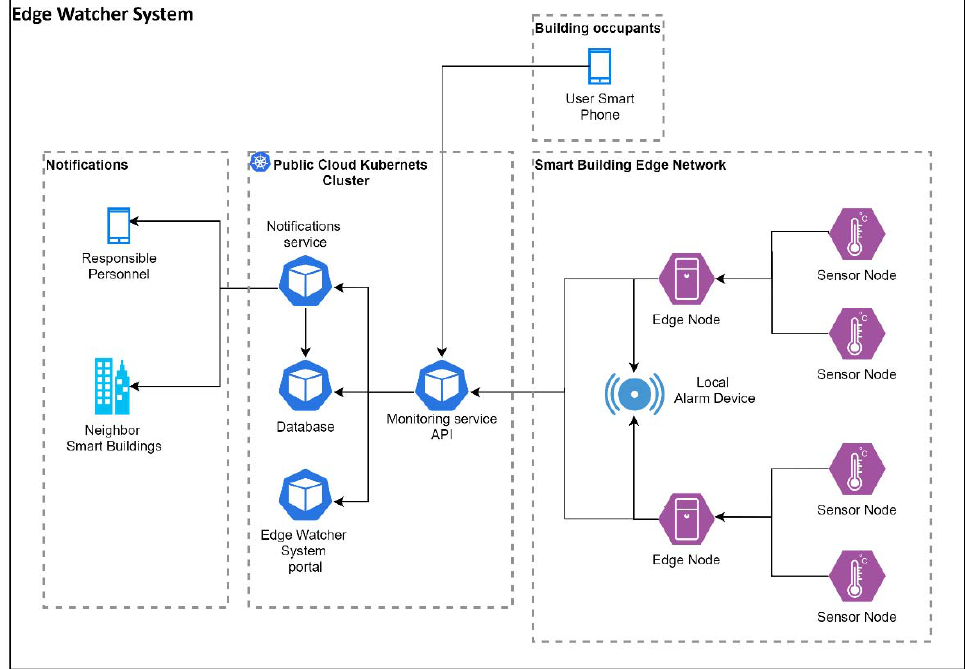
Figure 16. Edge Watcher System